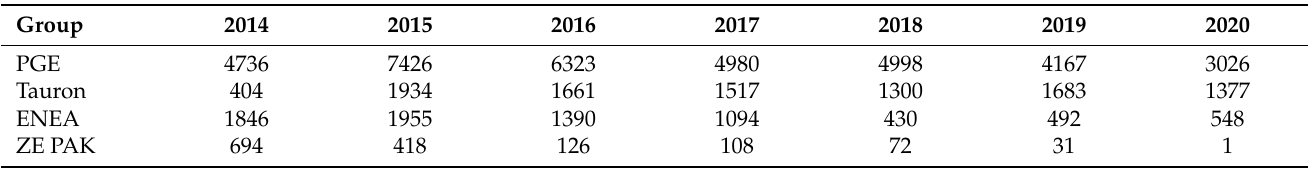
Table 20. Investment expenditure in PLN